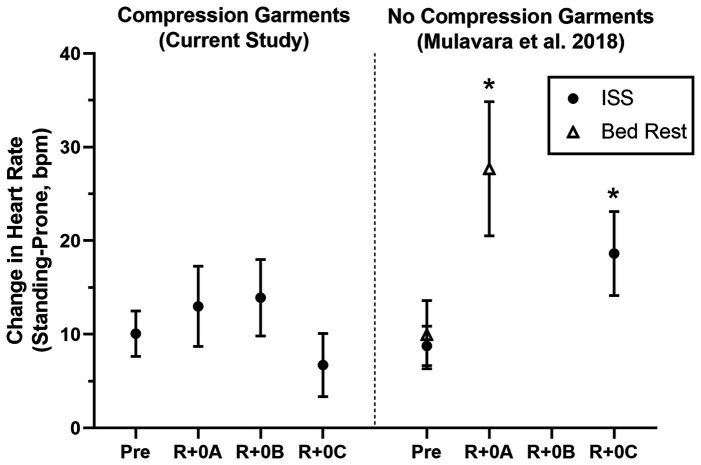
Mean change (±95% CI) in heart rate (Standing-Prone, bpm) in ISS astronauts (closed circles) participating in the current study who wore the GCG only during postflight tests (R+0A: 1.2–4.4 h; R+0B: 10.7–13.9 h; and R+0C: 25.6–30.7 h after landing) and in ISS astronauts (11 M, 2 F) and bed rest subjects (open triangles; 9 M) who participated in the same stand test protocol but did not wear compression garments (Mulavara et al., 2018). Results from these comparison groups of ISS astronauts and bed rest subjects are shown at time points comparable to the current study, and results were calculated in the same manner as in this study. *Significantly greater preflight to postflight change in the heart rate response to standing than when wearing the GCG.